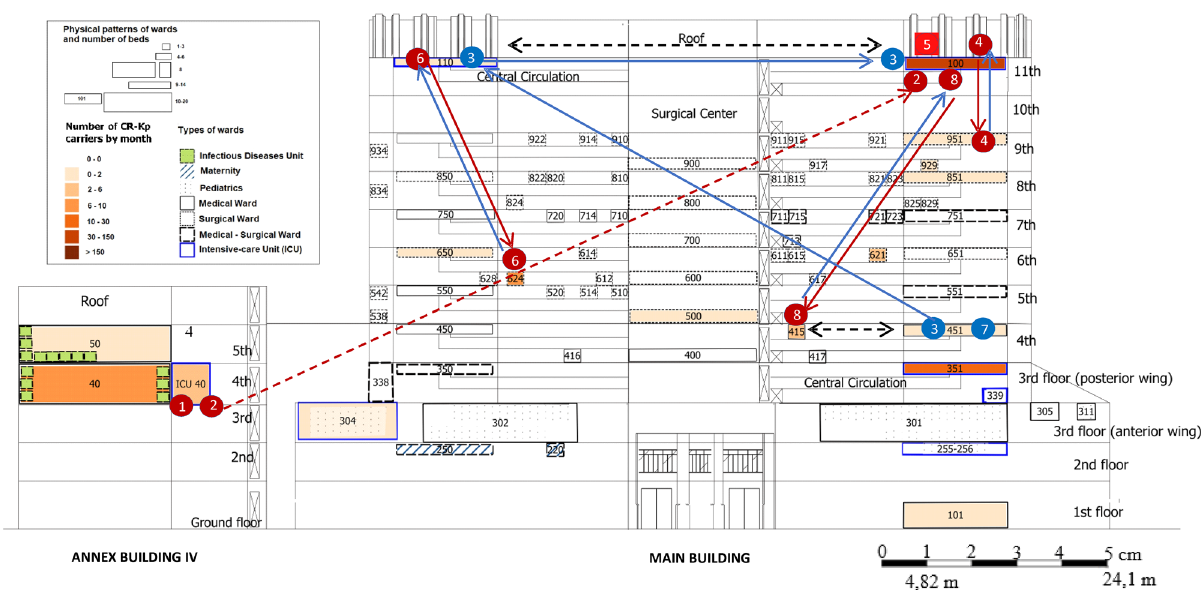
Figure 4. Space–time monthly distribution of patients harboring the carbapenem-resistant K. pneumoniae (CR- Kp) species complex and flow of cases (1–8) with polymyxin-carbapenem-resistant K. pneumoniae (PCR-Kp), by the hospital’s Geographic Information System 17 . Thematic hospital map in QGIS format (version 2.18, Open-Source Geospatial Foundation), federal tertiary hospital, Rio de Janeiro, December 2014 to August 2015 17 . The ward number is positioned in the center of its respective physical area. Patient numbers in red (ST437 PCR-Kp cases) or blue circles (ST11 PCR-Kp cases) ordered by the date of strain detection. K. pneumoniae complex isolate screened by the Vitek-2 system as PCR phenotype from case 5 (pink circle) was not preserved, but its AMR pattern (see Supplementary Table 2) was compatible with ST437 strains. The blue and red arrows represent the transfer of PCR-Kp infected cases before and after the detection of the PCR-Kp isolate, respectively. The dashed red arrow indicates that this patient was likely carrying PCR-Kp, although it had not yet been detected (see Table 1, PCR-Kp of cases 1 and 2 forms a subcluster of transmission). The dashed black arrow indicates that wards pertain to the same clinic or work as the same ICU. None of the cases had the opportunity for direct transmission to another case, considering the hospitalization unit and period. Superscript a: the number of patients in each ward or unit was counted monthly for the period of hospitalization after the first detection of CR-Kp